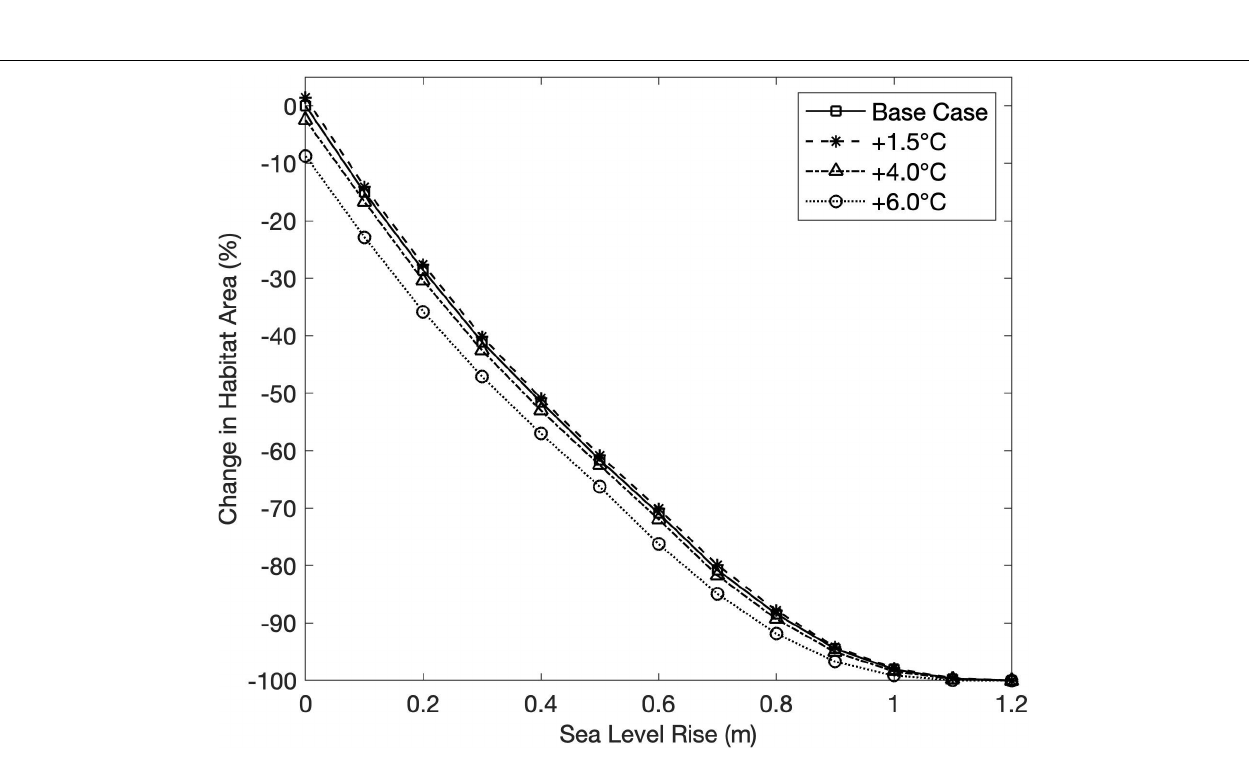
Frontiers in Marine Science |